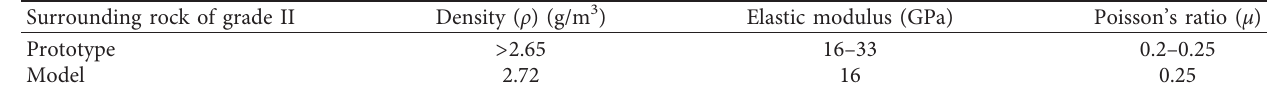
Table 1: Mechanical parameters of surrounding rock of grade II.